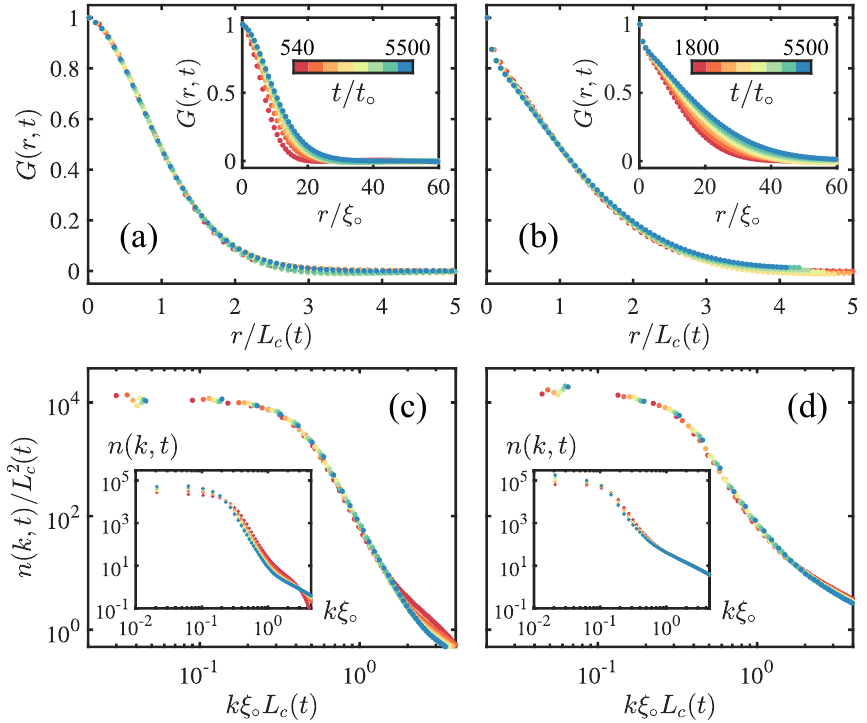
Figure 4: Collapse of correlation functions G ( r , t ) [ (a) and (b) ] and occupation number distributions n ( k , t ) [ (c) and (d) ] upon rescaling distances with the correlation ( t ) (insets show raw data, while main frames show the same curves after length L c rescaling). The left (right) column shows the results for n at eight equally spaced times over the range indicated in the color bar in (a) [ (b) ] . In (c) and (d), the total number of particles has been normalised to 10 5